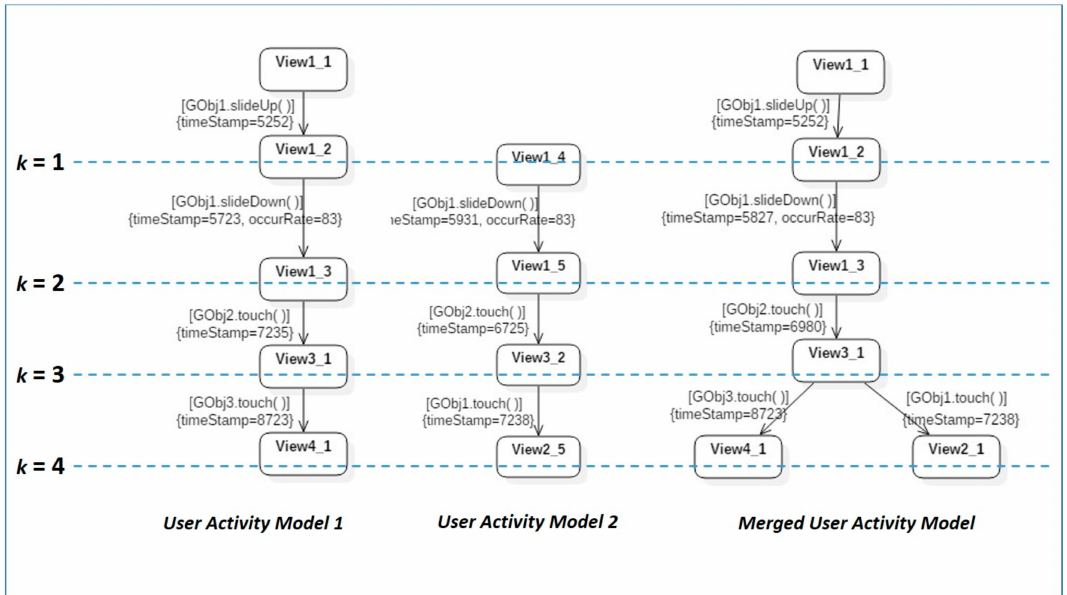
Figure 7. Applying Gk-tail algorithm to merge user activity